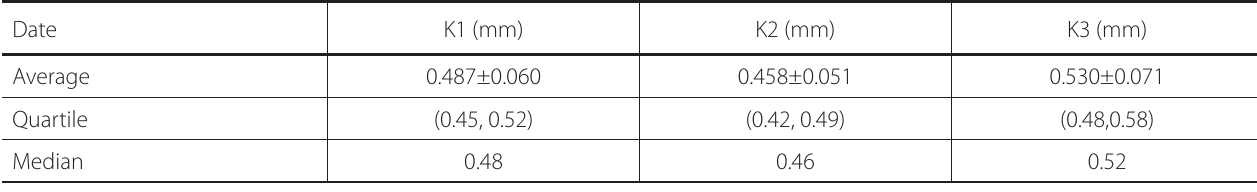
Table 1. Descriptive data for K1, K2 and